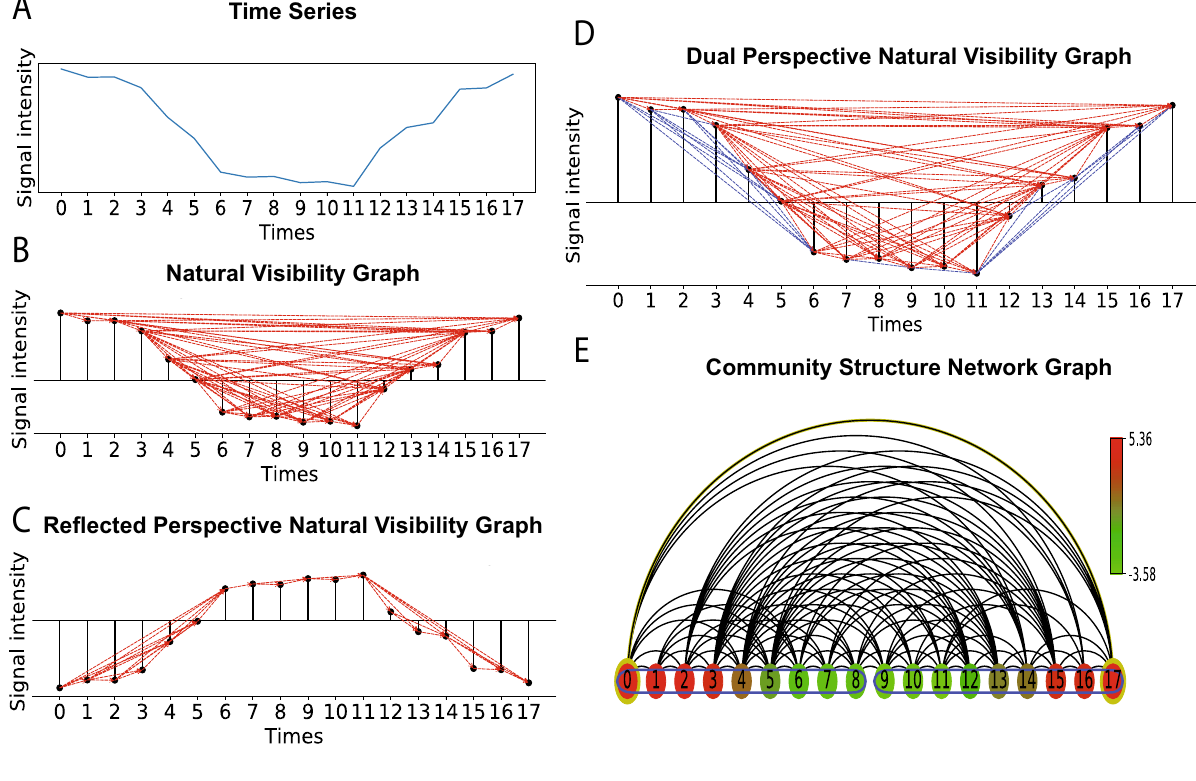
Figure 1. Illustration of the construction of weighted perspective visibility graph and community structure based on the shortest path length community detection method. ( A ) is the simulated time series cosine signal with 40% noise in intensity. We construct the weighted NVG and reflected NVG, where the edge weights are based on Euclidean distance. Edge connections of NVG and reflected NVG are illustrated in ( B ) and ( C ) respectively. The dual weighted perspective visibility graph is created by combining NVG and reflected NVG, as shown in ( D ), where the links with red color come from NVG, and the blue links come from the reflected NVG. Using our shortest path length based community detection method, we can find the community structure of the time series, as shown in ( E ). The time points in the same community are encircled by a blue outline, and the color of the nodes represents the signal intensity. The time series separates into two communities that capture the cosine signal’s